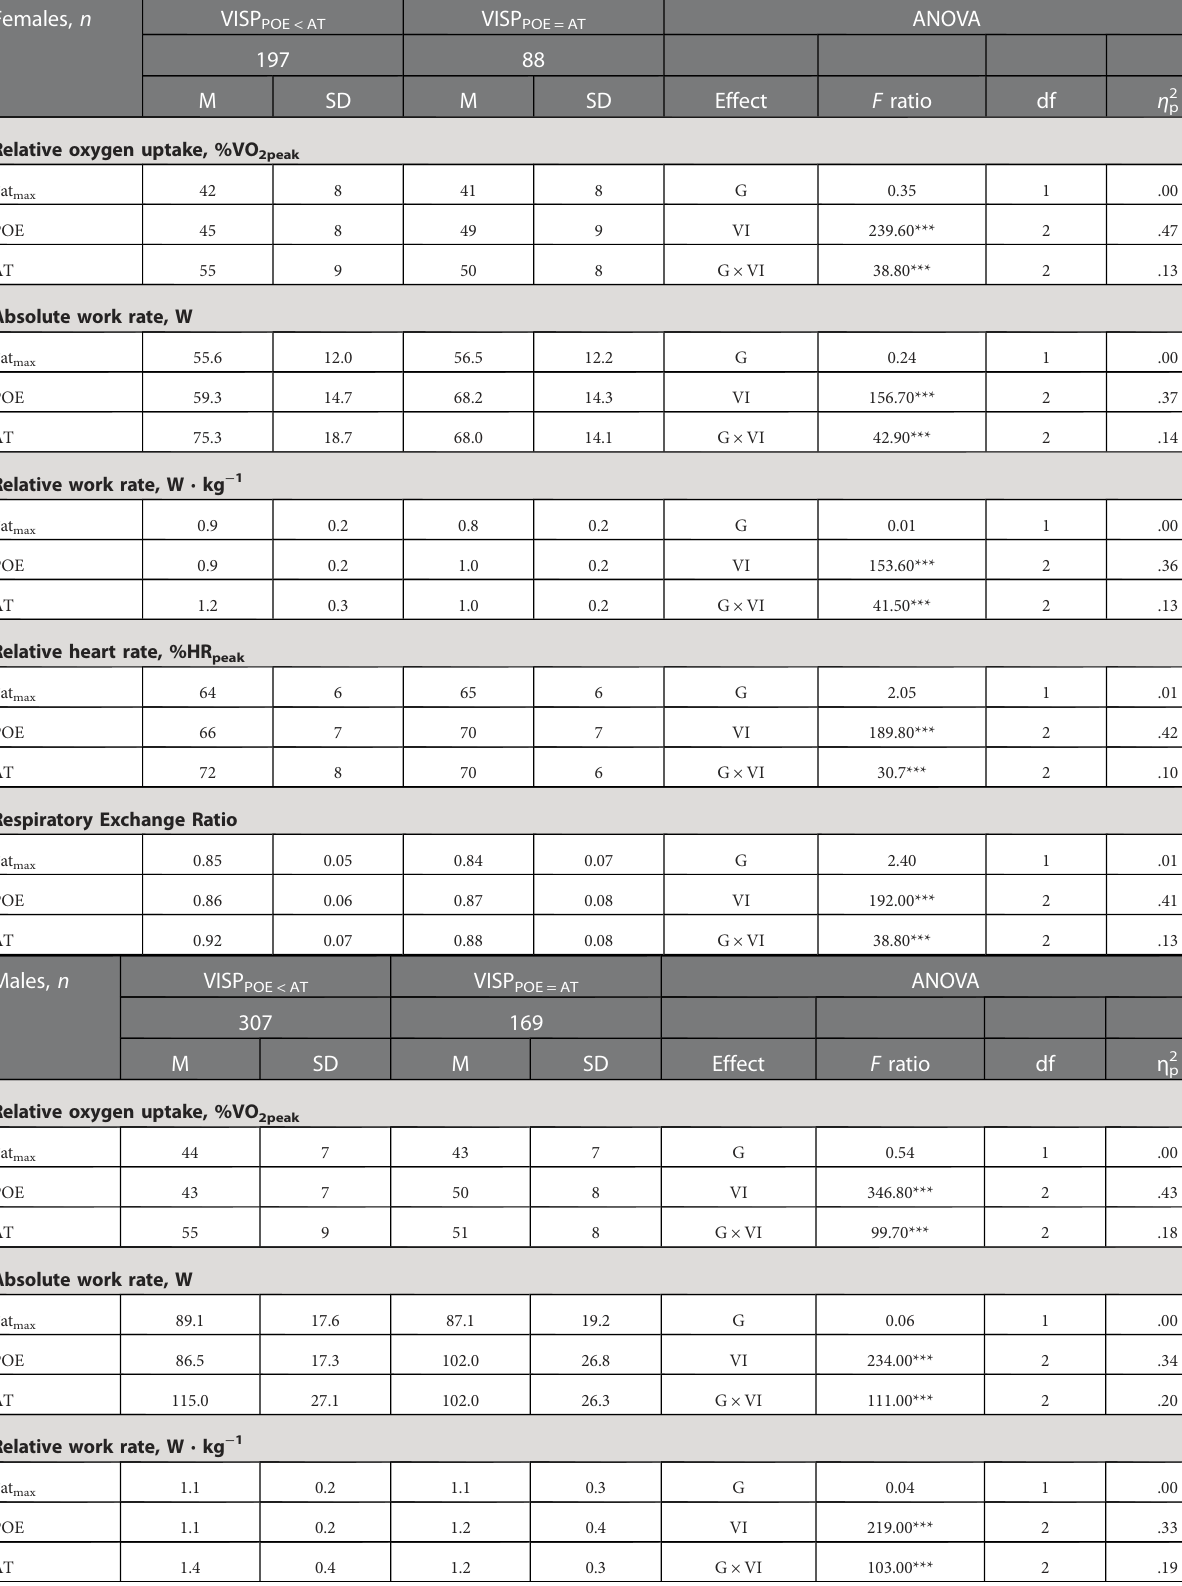
TABLE 4 Relative oxygen uptake, absolute and relative work rate, relative heart rate and respiratory exchange ratio at the ventilatory indices Fat max , POE and AT in VISP POE<AT and VISP POE=AT participants. Females, n VISP VISP POE<AT